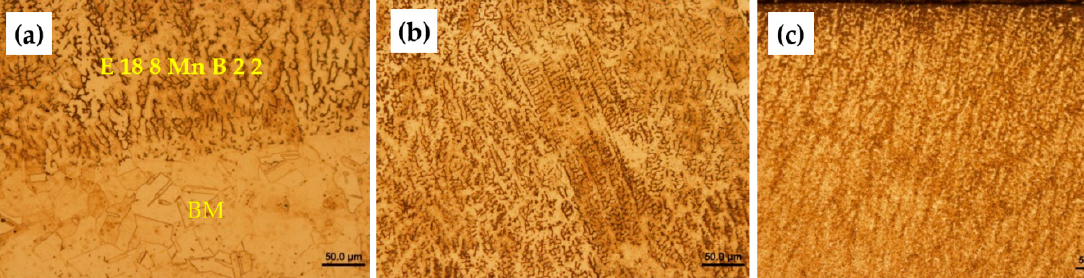
Figure 9. Microstructure of the three-layer CMT weld clad made using E 18 8 Mn B 2 2: fusion zone ( a ), middle part ( b ) and surface of the clad ( c ).